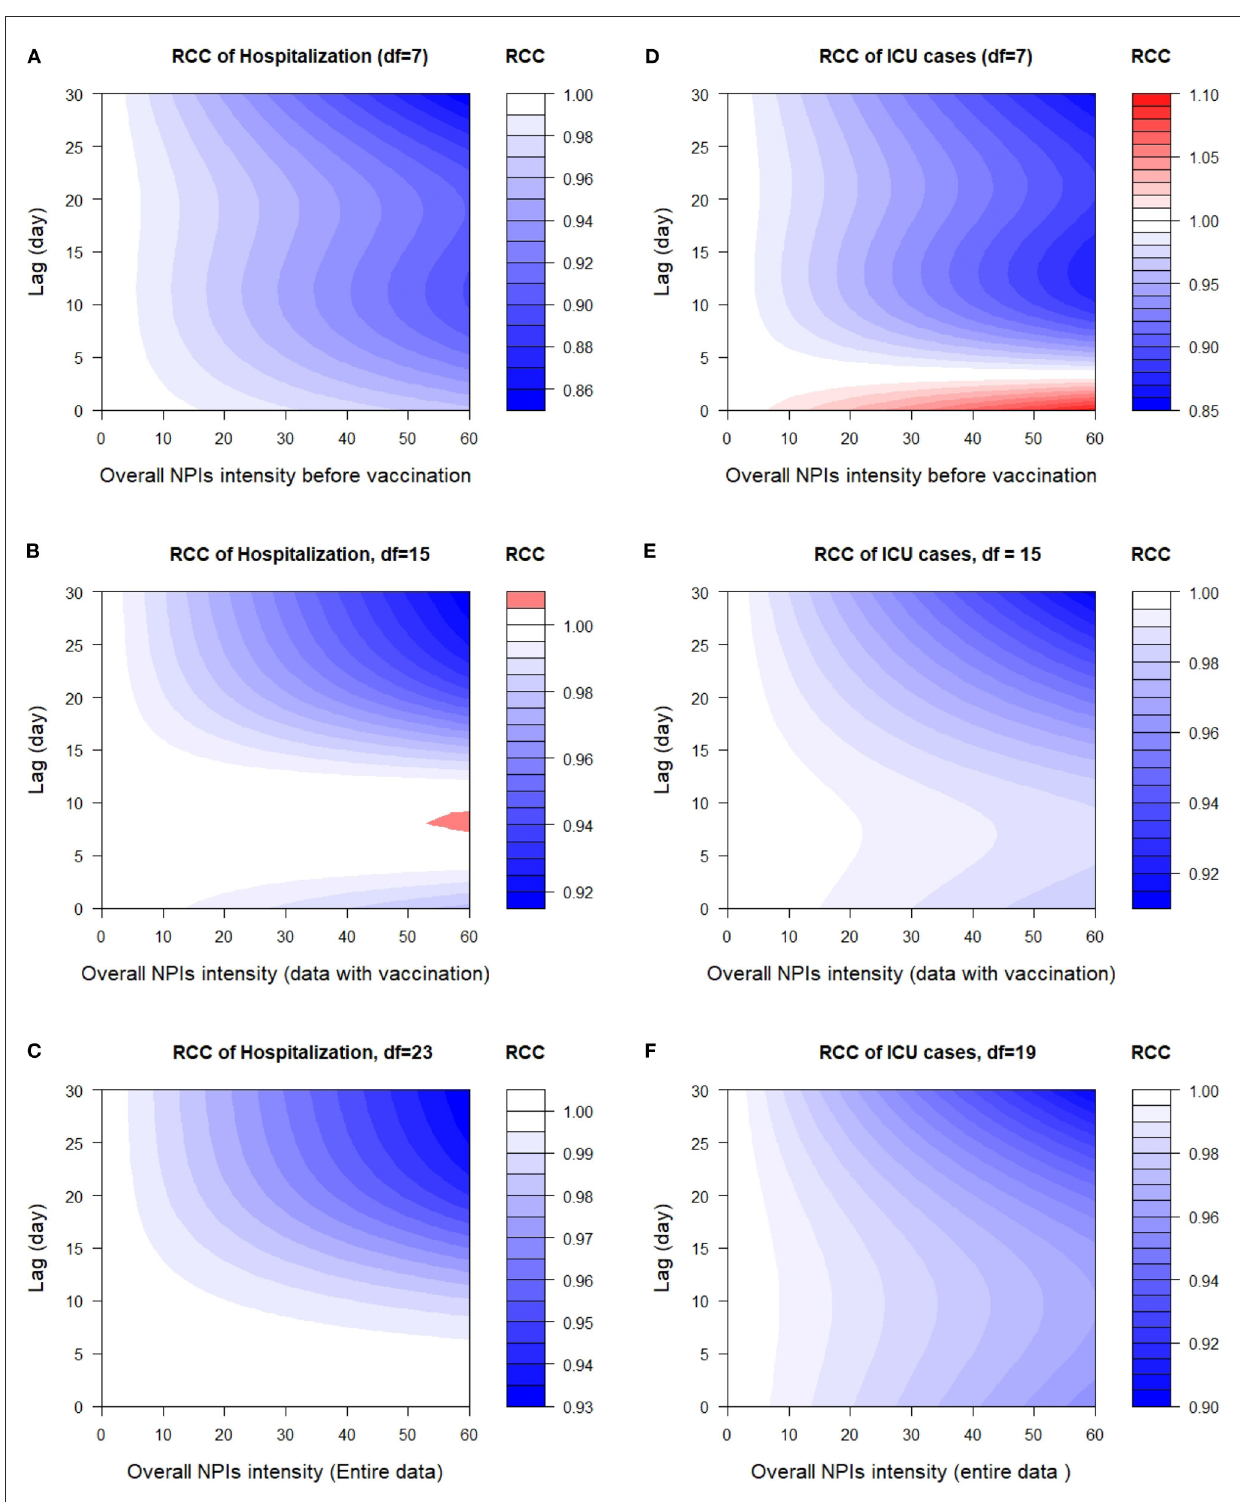
FIGURE1 2-D plot of relative count change (RCC) along NPIs and lags on the number of hospital patients (Hospitalized cases) and the number of prevalent intensive care patients (ICU cases). (A) RCC of Hospitalization (df = 7), (B) RCC of Hospitalization, df = 15, (C) RCC of Hospitalization, df = 23, (D) RCC of ICU cases (df = 7), (E) RCC of ICU cases, df = 15, and (F) RCC of ICU cases, df =